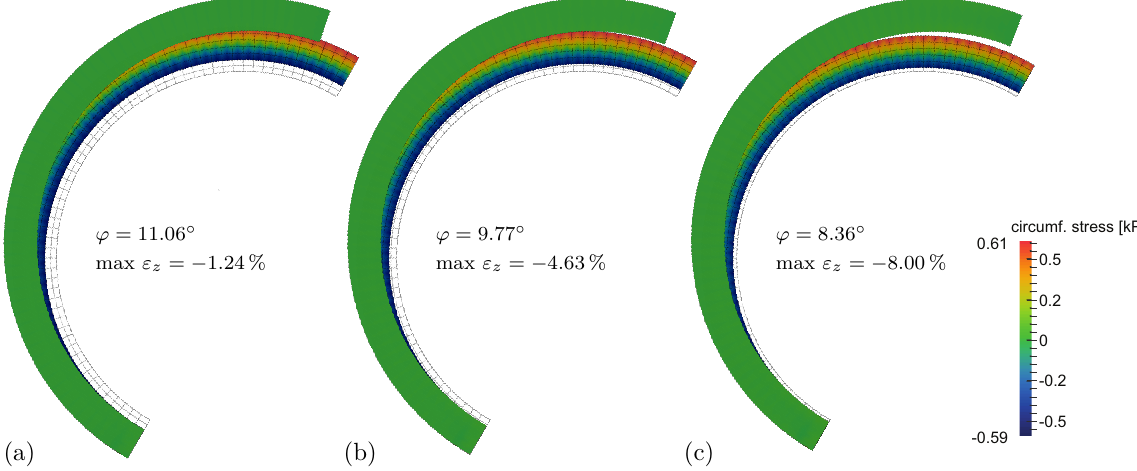
Figure 4. Deformation states associated to the residual stresses in arterial segments loaded by an internal pressure and axial displacements of (a) 10 %, (b) 15 % and (c) 20 % of the initial length. The wireframe shows the undeformed reference configuration, whereas the second chart form the inside shows the grown state after removal of the pressure. The indicated values of axial strain have been computed with respect to that deformed